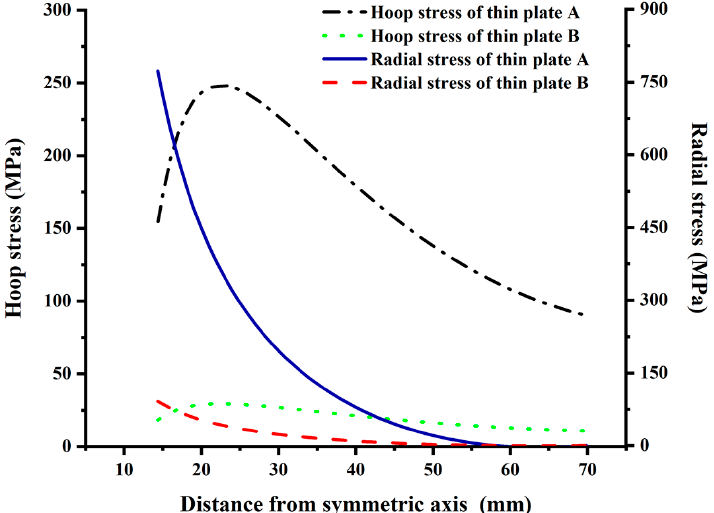
Figure 10. Radial and hoop stress distribution on the loading surface. Note: The radial and hoop stress of the tray free surface are symmetrical to the corresponding stress of the loading surface on the transverse axis, so the diagram is not drawn.